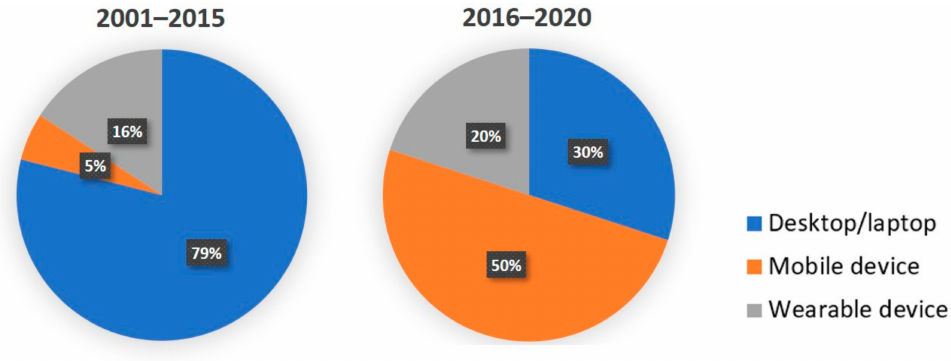
Figure 5. Computing devices of AR-supported instruction in the periods of 2001–2015 and 2016–2020. Table 2. Media presentation of AR-supported instruction in three